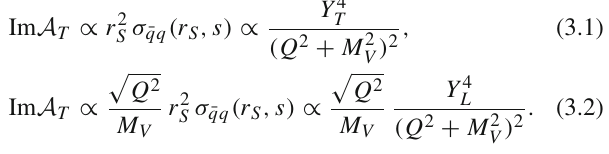
Fig. 1 The Q 2 dependence of the scale parameters Y T and Y L defining the magnitude of the scanning radius, Eq. (1.1), is shown for production of T and L polarized J /ψ( 1 S ) (upper boxes) and ψ (cid:2) ( 2 S ) (lower boxes) vector mesons. The solid and dashed curves represent the values of Y T and Y L with and without effects of Melosh spin rotation, respectively. The thin and thick curves correspond to production of L and T polarized vector mesons, respectively. The calculations have been performed with the vector meson wave function using the realistic Buchmüller–Tye [31] (left boxes) and power-like [32] (right boxes) potential